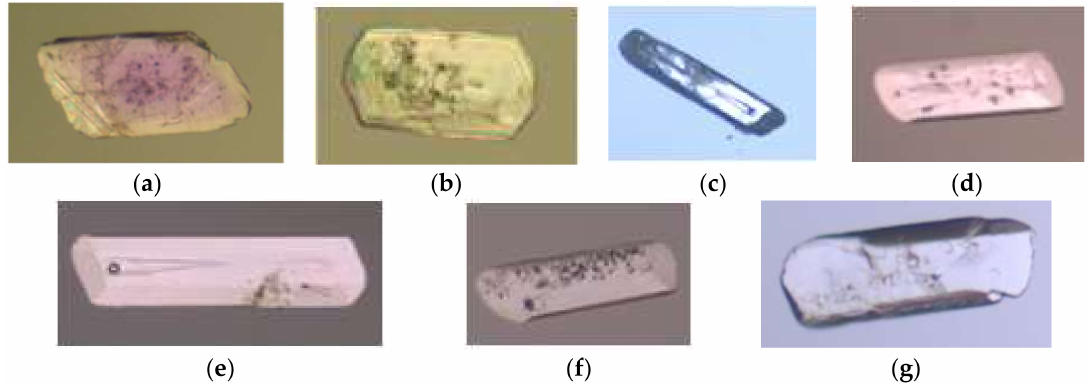
Figure 2. Color and shape of {Zn-M-BTC}{Me 2 NH 2 + } crystals doped with ( a ) Co, ( b ) Cu, ( c ) Ni, ( d ) Mn, ( e ) Ca, ( f ) Mg, and ( g ) Cd.